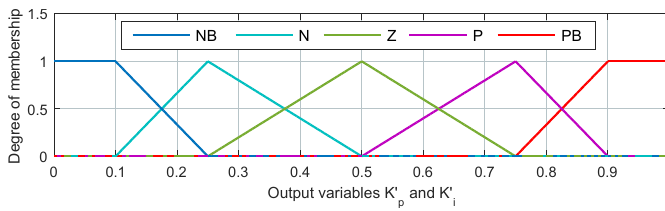
Figure 14. Membership functions for outputs K (cid:48) p , K (cid:48)